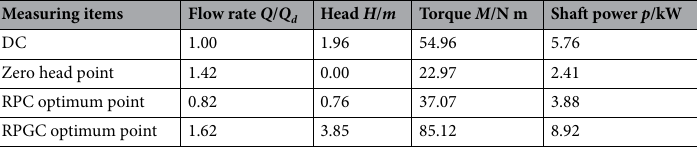
Table 3. External characteristic parameters of key operating points under special utilization conditions.